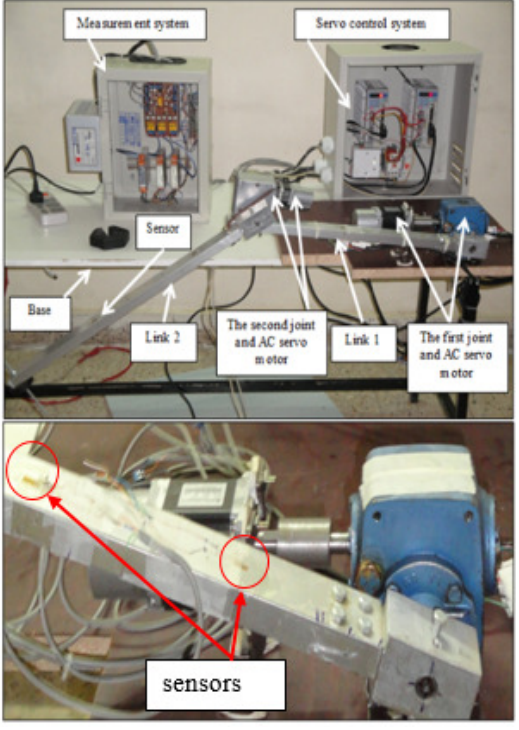
Fig. 6. the two degrees robot arm manipulator and the strain gages